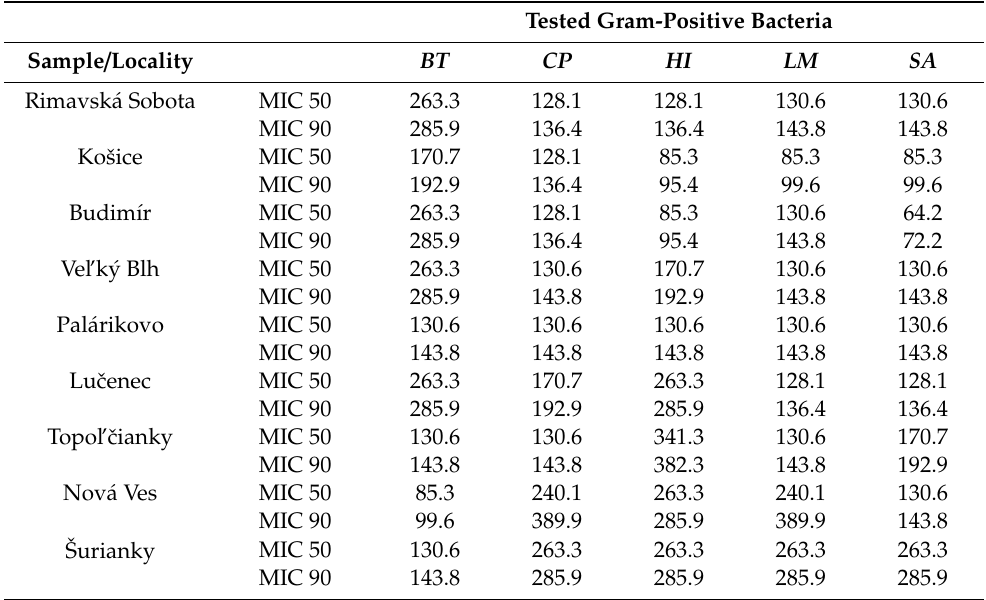
Tested Gram-Positive Bacteria